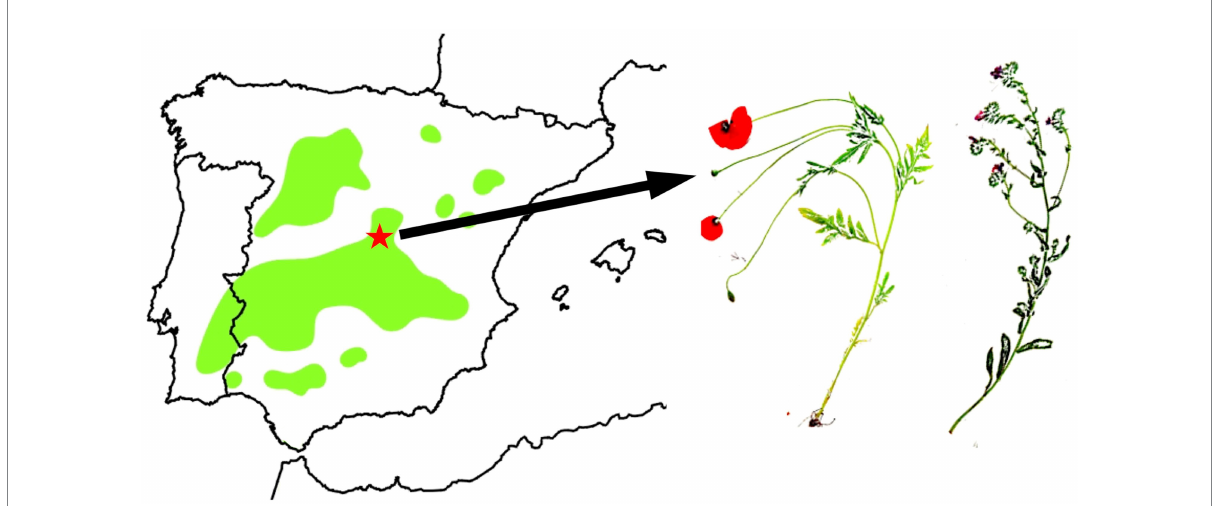
FIGURE 2 Great Bustard distribution in the Iberian Peninsula (green areas). E. plantagineum (right) and P. rhoeas (middle) were collected in central Spain (red star: Valdetorres del Jarama, Madrid) within the Great Bustard area distribution. Map distribution from SEO/BirdLife (2015) updated with own